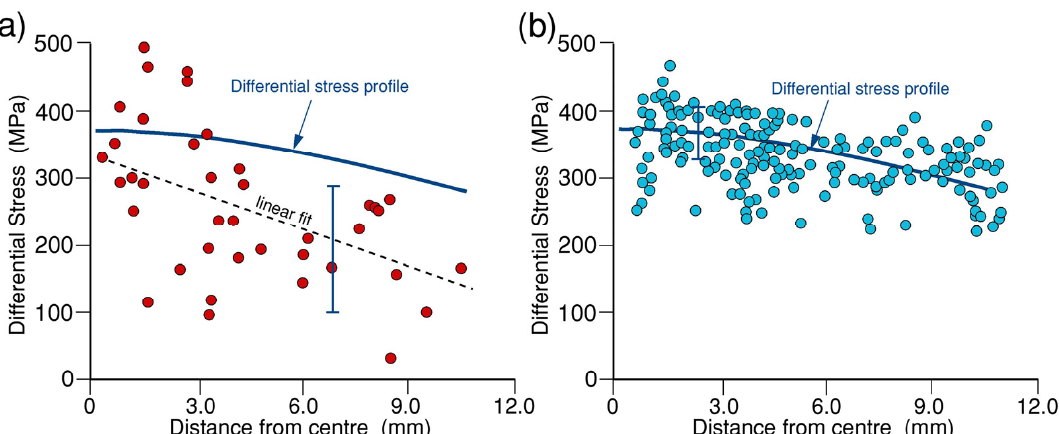
Figure 15. Back calculation of the variation in differential stress with distance along the sample axis using twin density data (twin set #1): ( a ) Using measured shear stress resolved along the twin displacement vector and shear stress calculated from Equation (1), Schmid factors calculated from measured angles λ and ∅ ; set of most frequent twins in 40 grains. Standard error in stress ± 95 MPa; ( b ) All of the twin sets in all of the 181 twinned grains, Differential stresses calculated from Equation (2), Standard error in stress ± 41 MPa.